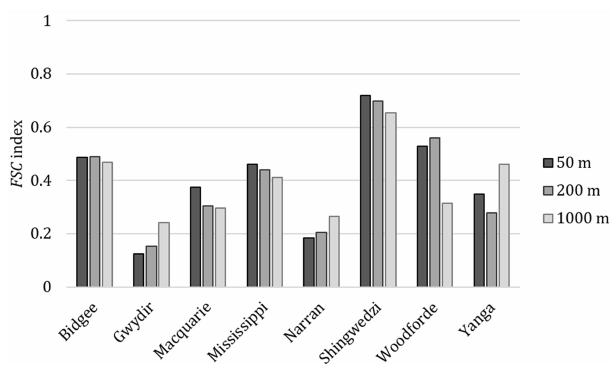
Figure 2. Index of floodplain surface complexity (FSC) for the eight floodplains at each of the three window sizes.